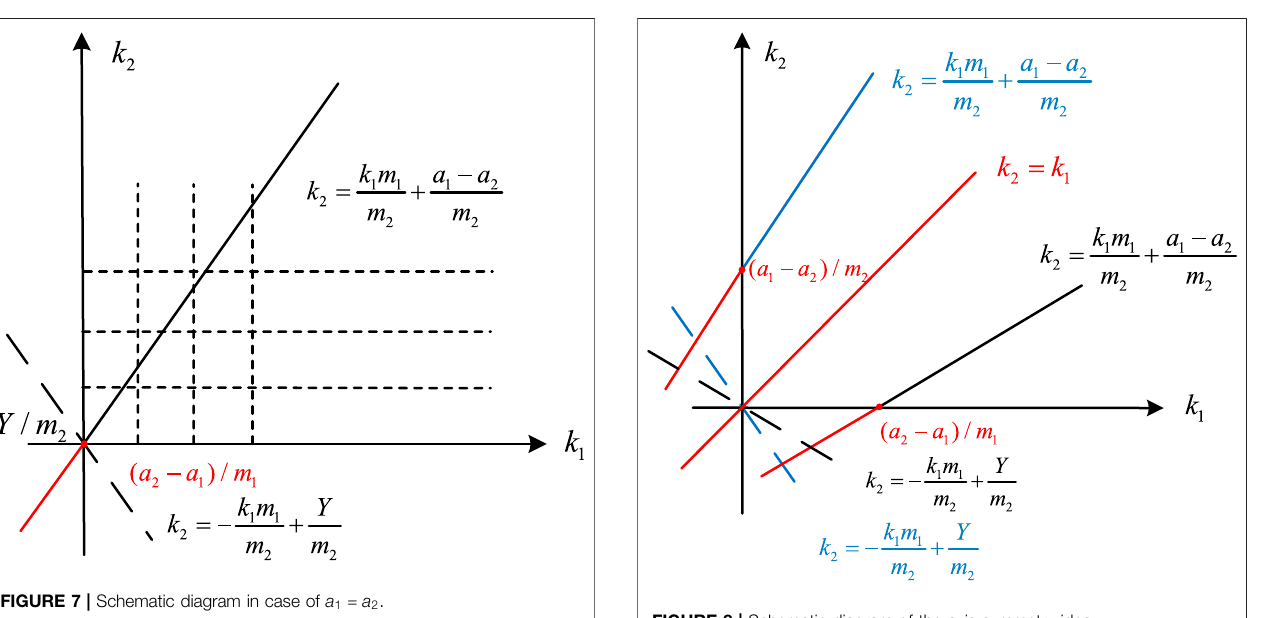
FIGURE 8 | Schematic diagram of the axis symmetry